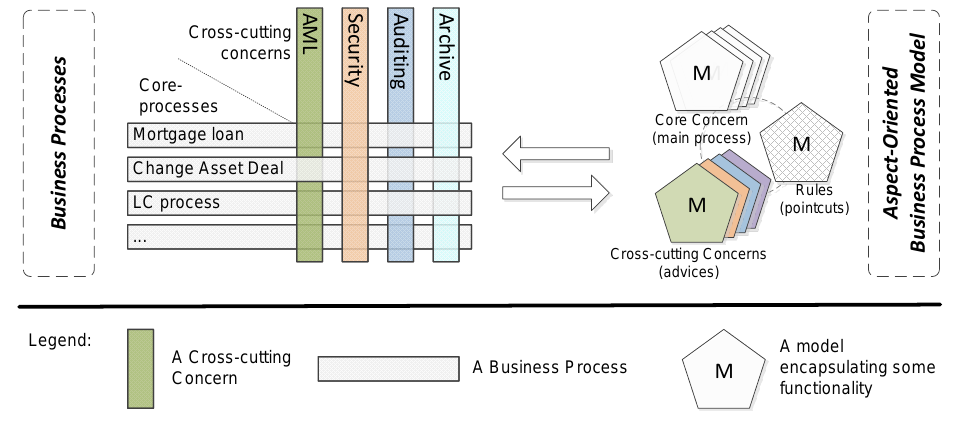
Figure 2. Aspect-Oriented Business Process Modelling, adopted from